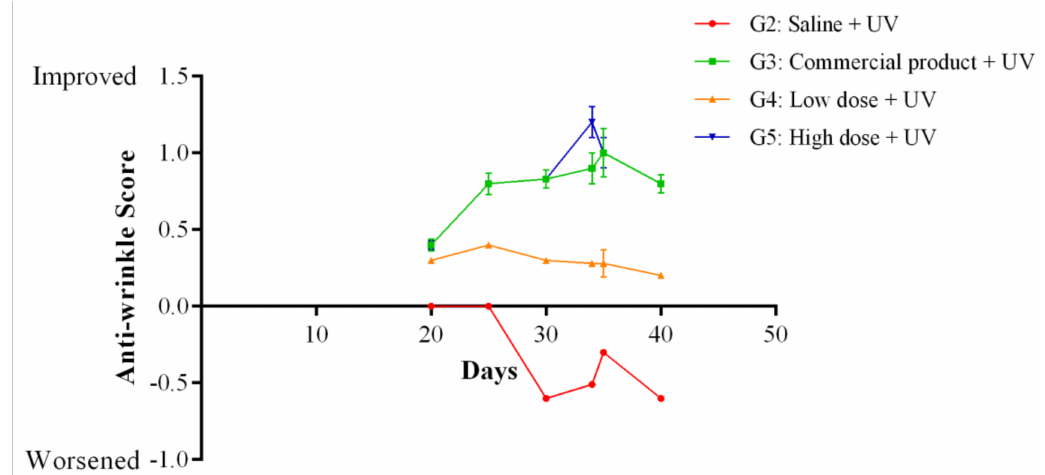
Figure 6. Anti-wrinkle score measurement. The commercial product and the PPEE-SLNs formulations showed a statistically significant increase in the anti-wrinkle activity compared to the control group (G2). 5% PPEE-SLNs (G5) showed comparable activity to the commercial product (G3). p < 0.05 / n =